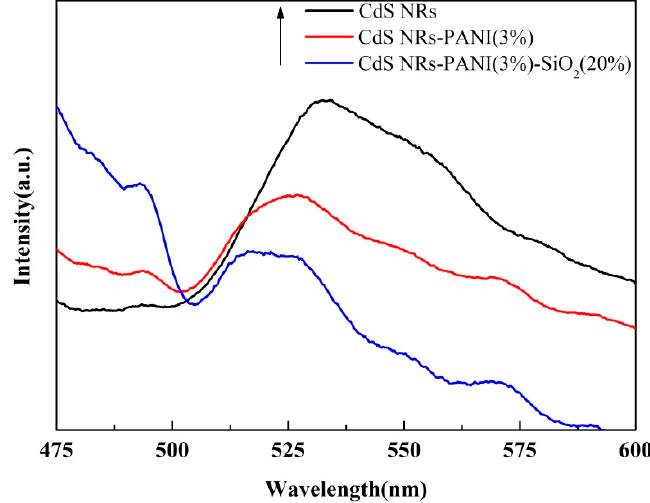
Figure 6. Photoluminescence spectra of CdS NRs, CdS NRs-PANI (3%), and CdS NRs-PANI (3%)-SiO 2 (20%).